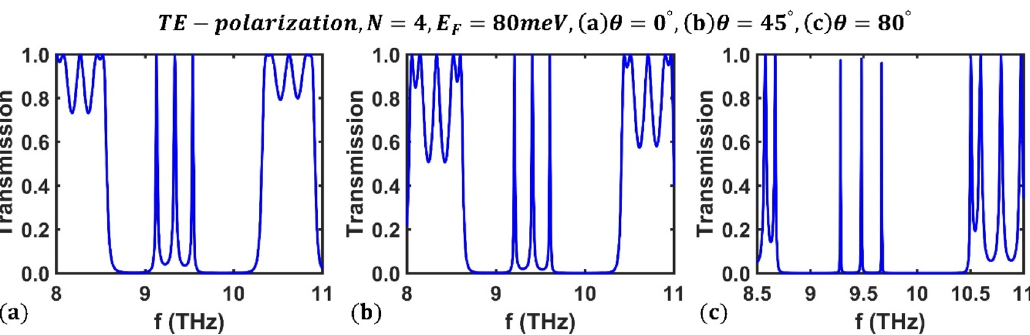
Figure 5. Transmission spectrum of the third-order F-1D PhC for TE polarization state corresponding to fixed values of Fermi energy and period number as E F = 80 meV and N = 4 , respectively, at incident angles ◦ ◦ ◦ ( a ) θ = 0 , ( b ) θ = 45 , and ( c ) θ = 80